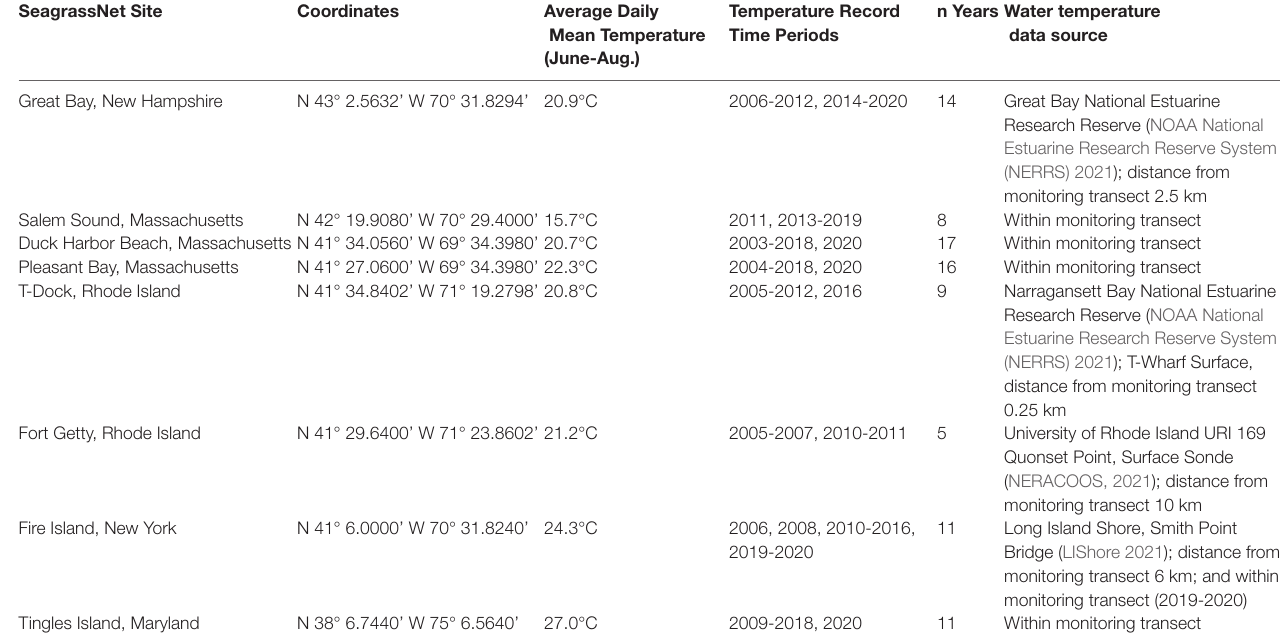
TABLE 1 | SeagrassNet site locations and time period average of the daily average summertime water temperatures (used for centering) within each site. SeagrassNet Site